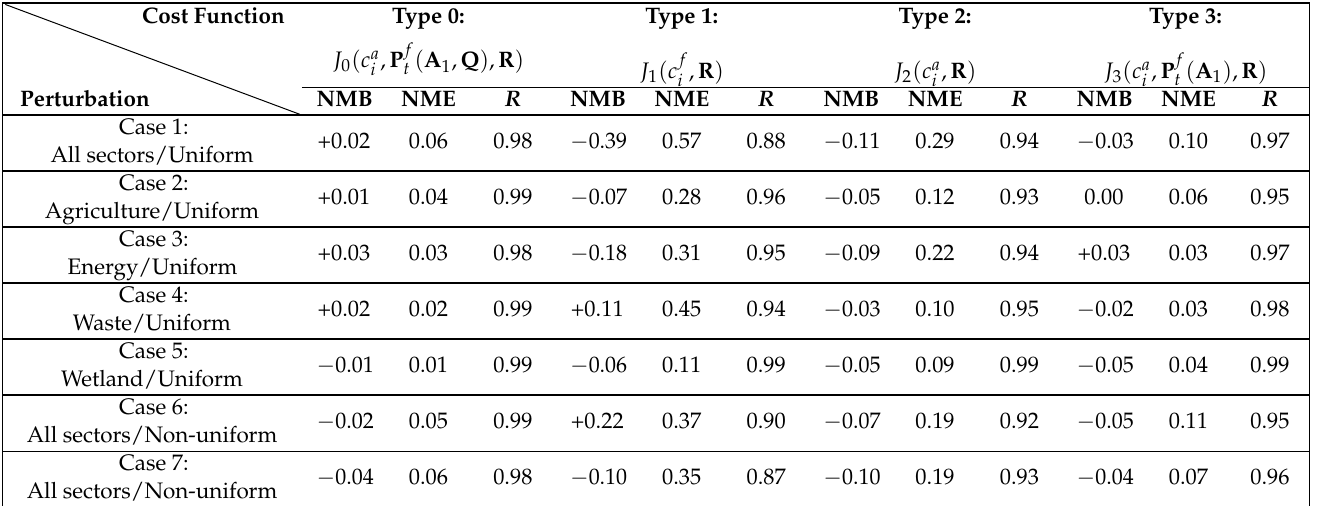
Table 3. Normalized mean bias (NMB), Normalized mean error (NME), and Pearson’s correlation coefficient ( R ) for each perturbation case and inversion cost functions (Equations (7)–(10)). In cases 1–5, sector/sectors are all uniformly scaled up by 50%. In cases 6 and 7, sectors are perturbed non-uniformly between 25–50% (see Section 3.3 for the